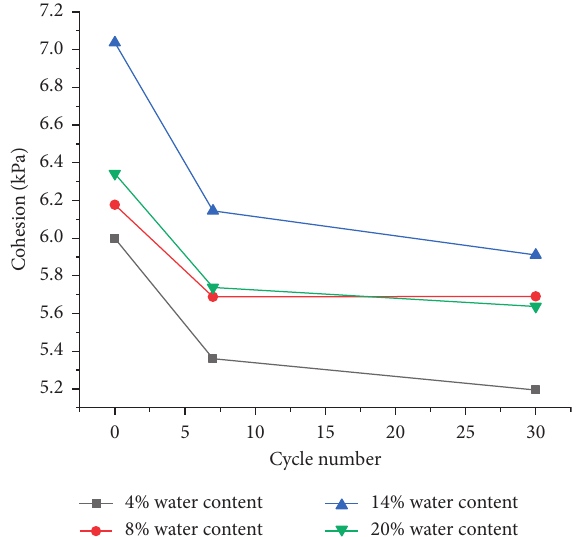
Figure 16: The cohesion-cycle number curve with different water content.